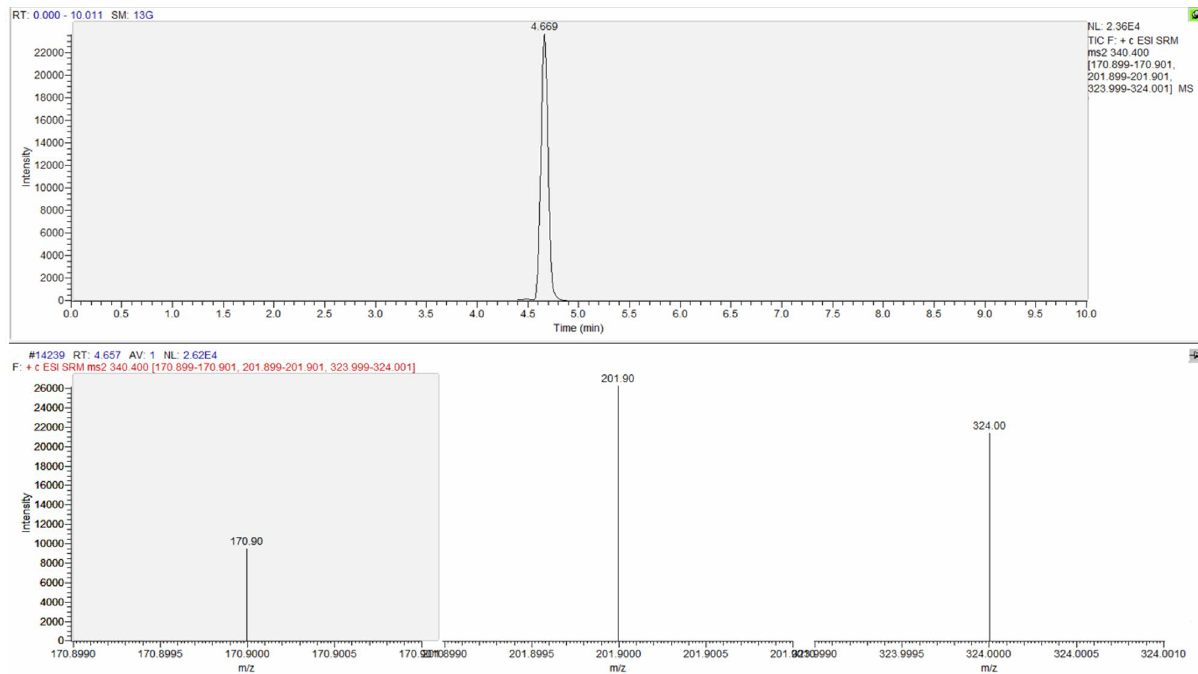
Figure 6. Chromatographic spectrum (upper raw) and mass spectral ion ratio (lower portion) of papaverine detected in C3.